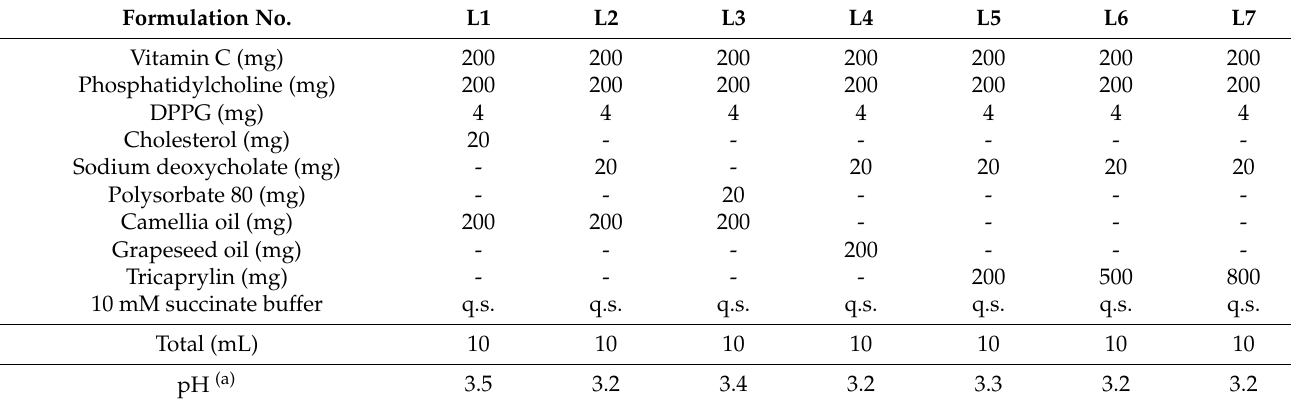
Table 1. Compositions of Vit C-loaded lipo-oil-somes (LOSs) formulated with different edge activators and neutral